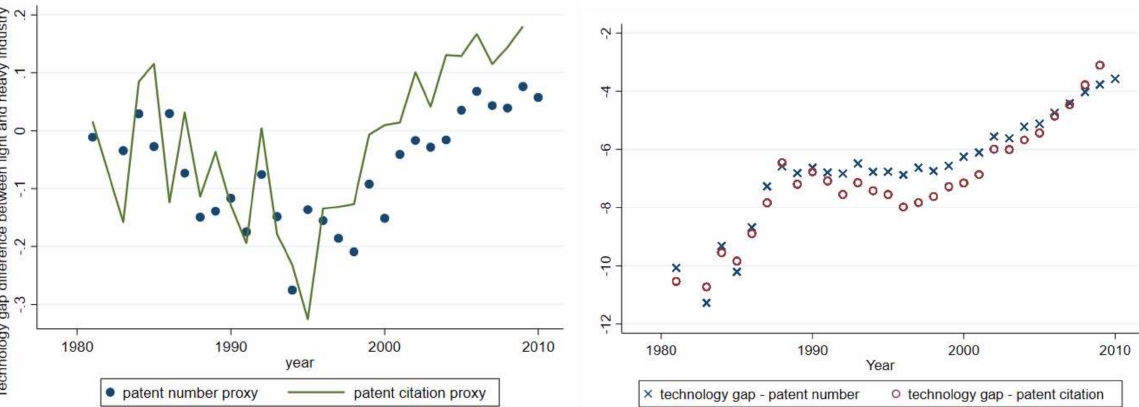
Figure 2. Technology gap in light industry and heavy industry from 1982 to 2010 in